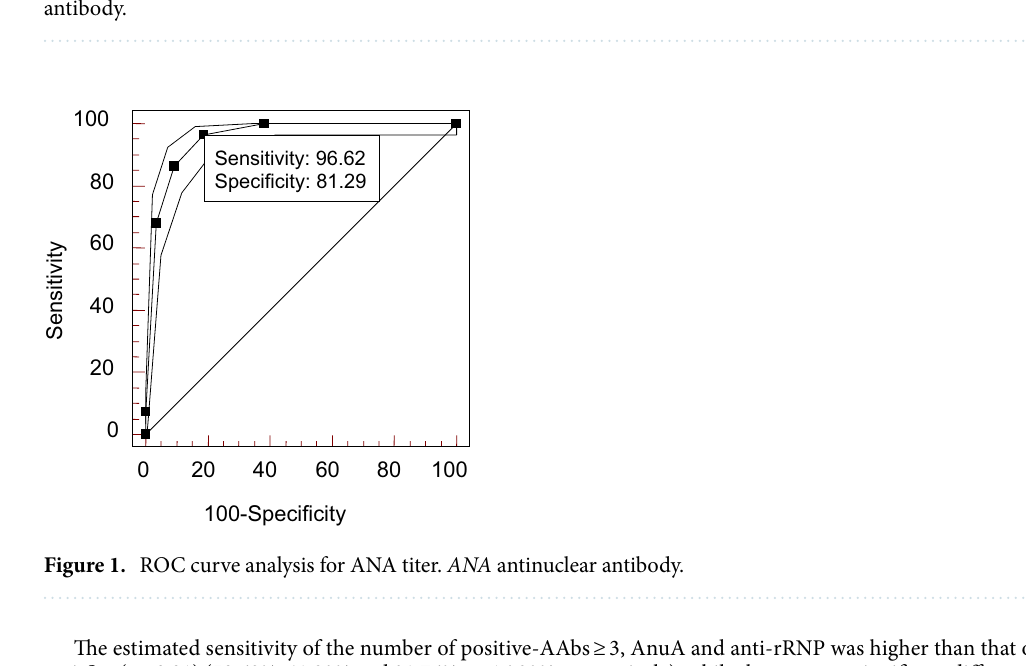
Table 4. The specificity of ANA titer, the number of positive-AAbs in ANAs and various AAbs for SLE. * p < 0.01, compared with anti-Sm. ▲ p > 0.05, compared with anti-Sm. ANA antinuclear antibody, ANAs antinuclear antibodies, AAbs auto-antibodies, SLE systemic lupus erythematosus, + LR the estimated positive likelihood ratio, − LR the estimated negative likelihood ratio, anti-U1RNP anti-U1 ribonucleoproteins, anti-Sm anti-Sm antibody, AnuA anti-nucleosome antibody, anti-rRNP anti-ribosome ribonucleoprotein antibody, anti-dsDNA anti-dsDNA antibody, AHA anti-histone antibody, anti-SSA anti-SSA antibody, anti-SSB anti-SSB antibody.